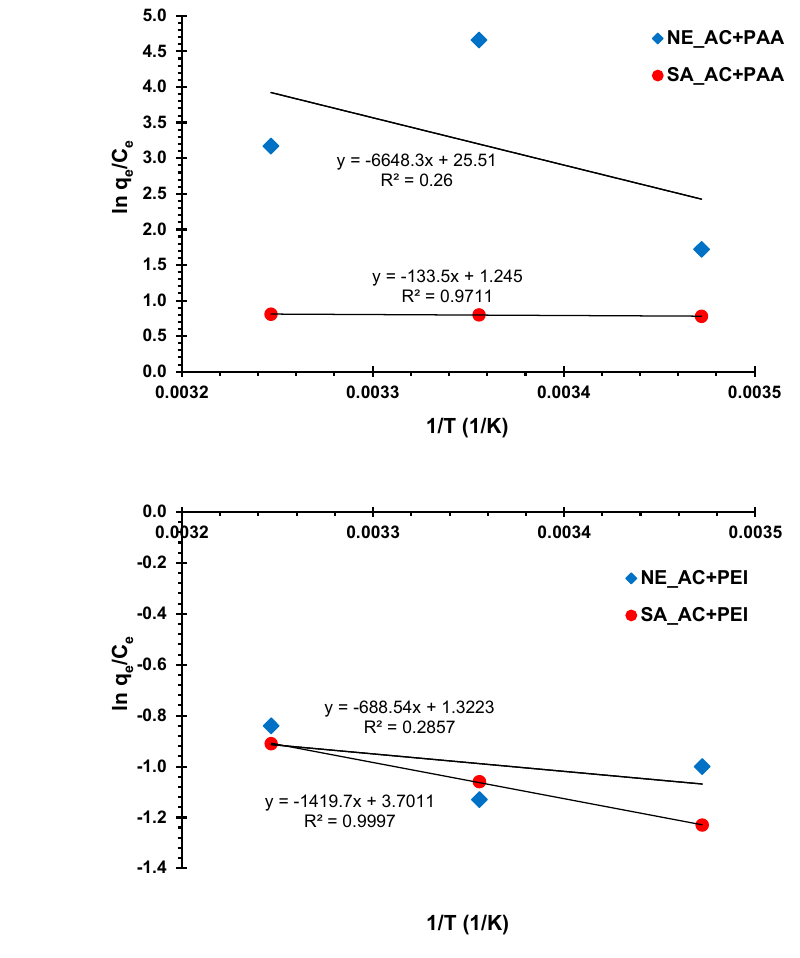
Figure 7. The van’t Hoff plots for calculation of enthalpy and entropy in ( a ) PAA and ( b ) PEI—activated carbon systems. Table 5. Thermodynamic parameters of PAA and PEI adsorption on activated carbons surface.